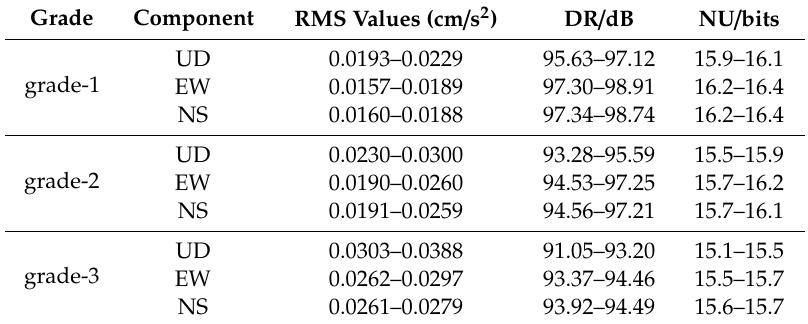
Table 3. Estimated dynamic range (DR) and useful resolution (NU) of each grade of the GL-P2B stations. Grade Component RMS Values (cm / s 2